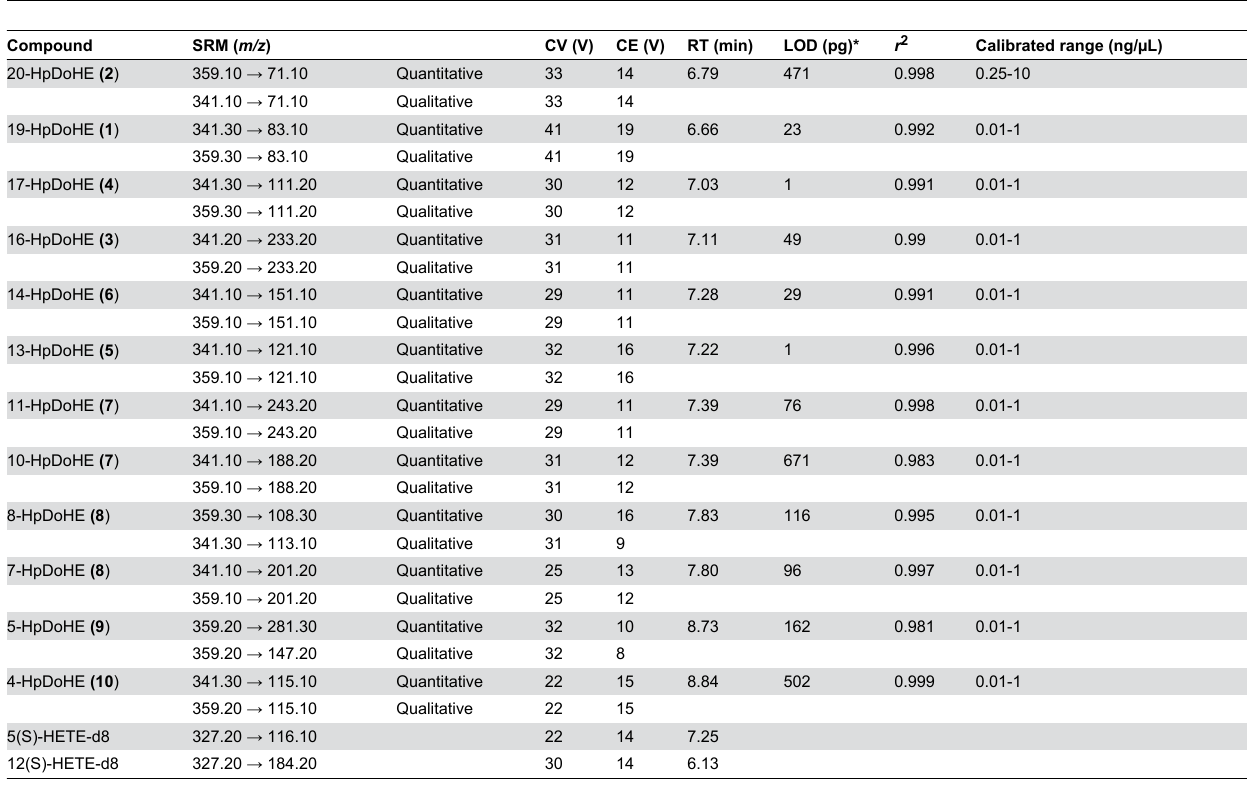
Table 1. Optimized mass conditions for LC-MS/MS method for HpDoHE.